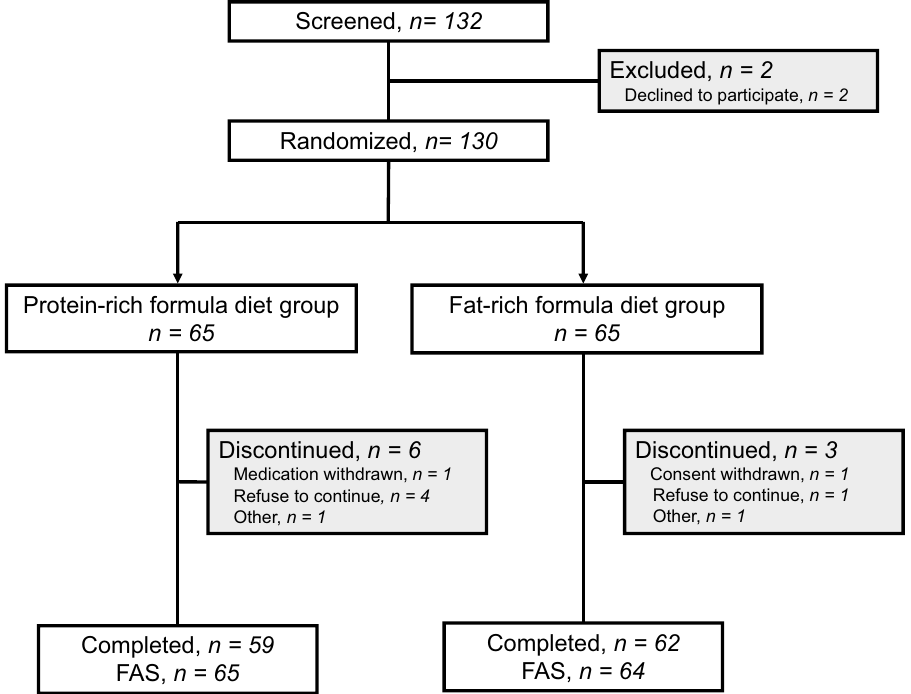
Figure 1. Diagram of participant flow. A total of 121 patients completed the study (59 in protein-rich formula diet group and 62 in fat-rich formula diet group). FAS full set analysis.